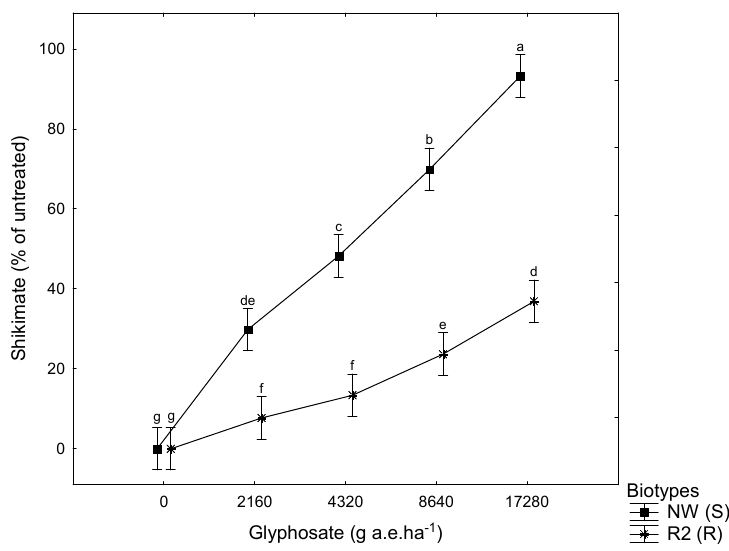
Figure 3. Shikimate accumulation in susceptible NW (S) and putative resistant R2 (R) plantago ( Plantago lanceolata L.) after application at various glyphosate dosages rates. Means indicated by different letters differed significantly at p ≤ 0.05 according to Fishers LSD. Means are pooled from two experiments. Vertical bars denote ± standard error of the